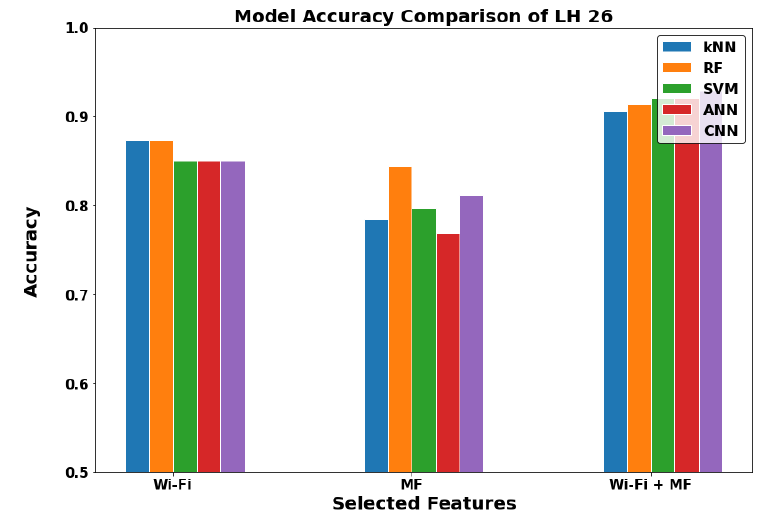
Figure 14. The models comparison in Lecture Hall 26 (Indoor).